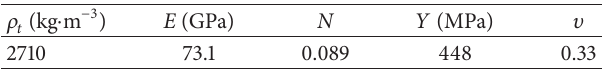
Table 3: Power-law constitution parameters of 7075-T651 alu- minum [4].